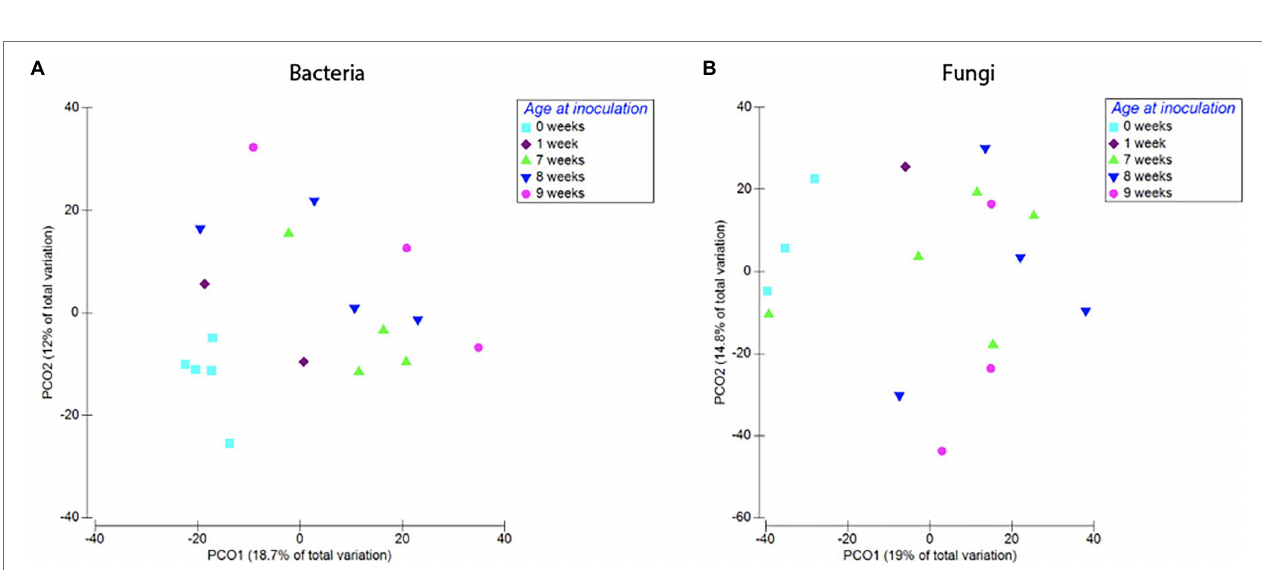
FIGURE 7 | Compositional differences in bacterial (A) and fungal (B) communities of roots harvested at 12 weeks. Plants inoculated at different developmental stages hosted distinct bacterial (Pseudo- F = 1.45, p = 0.008) and fungal communities (pseudo- F = 1.38, p = 0.03). Dots represent pairwise differences (measured as Bray–Curtis